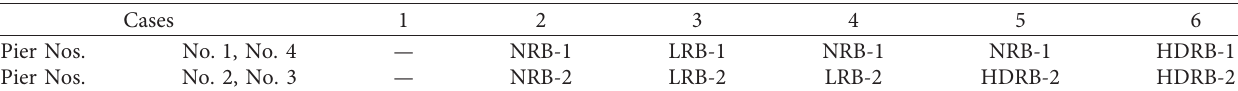
Figure 5: Layout and restoring force model of bearings: (a) restoring force model of NRB; (b) bilinear restoring force model of LRBs and HDRBs. Table 1: Case setting of